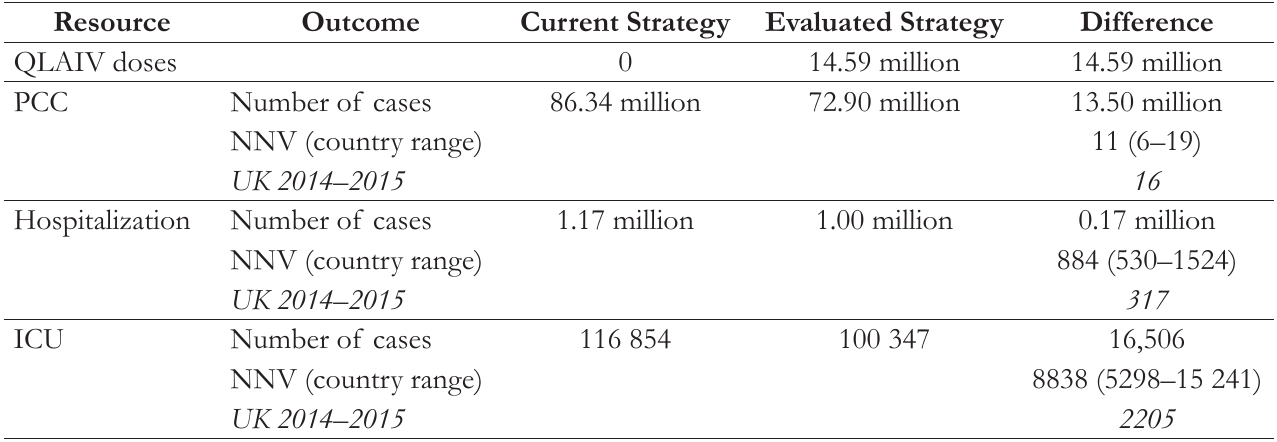
Table 4. NNV with QLAIV per Prevented Event in the Total Population, Model versus UK 2014–2015 Outcomes